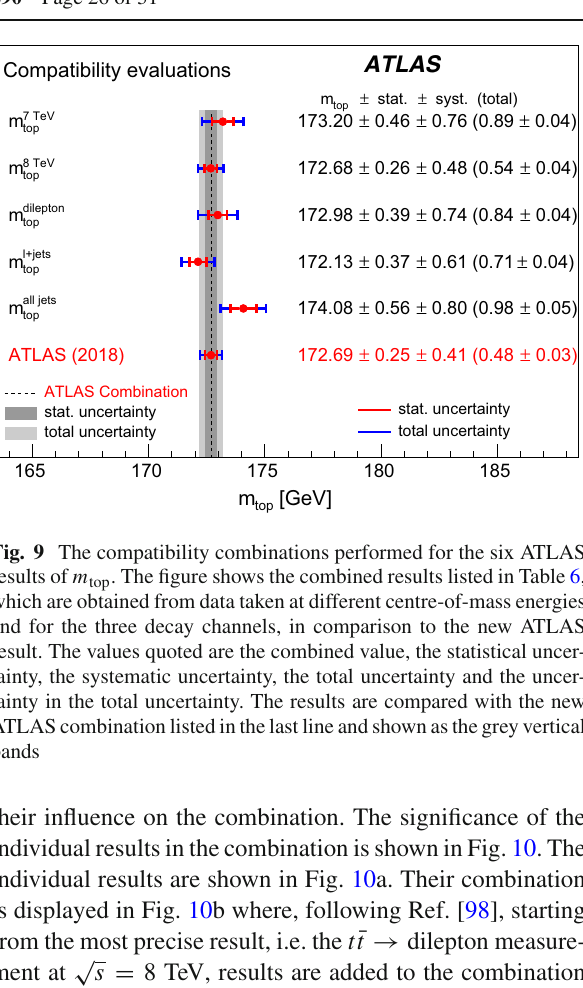
the three results per centre-of-mass energy resulting in uncorrelated results m 7TeV top and m 8TeV top . The middle part is for the combination of the three observables from pairs of results per t ¯ t decay channel, resulting in correlated results m dilepton